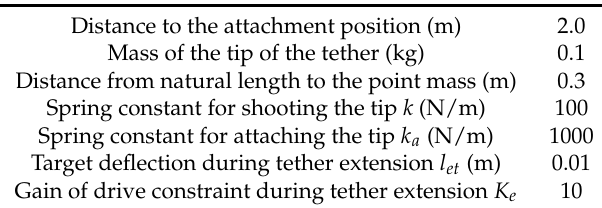
Table 3. Calculation